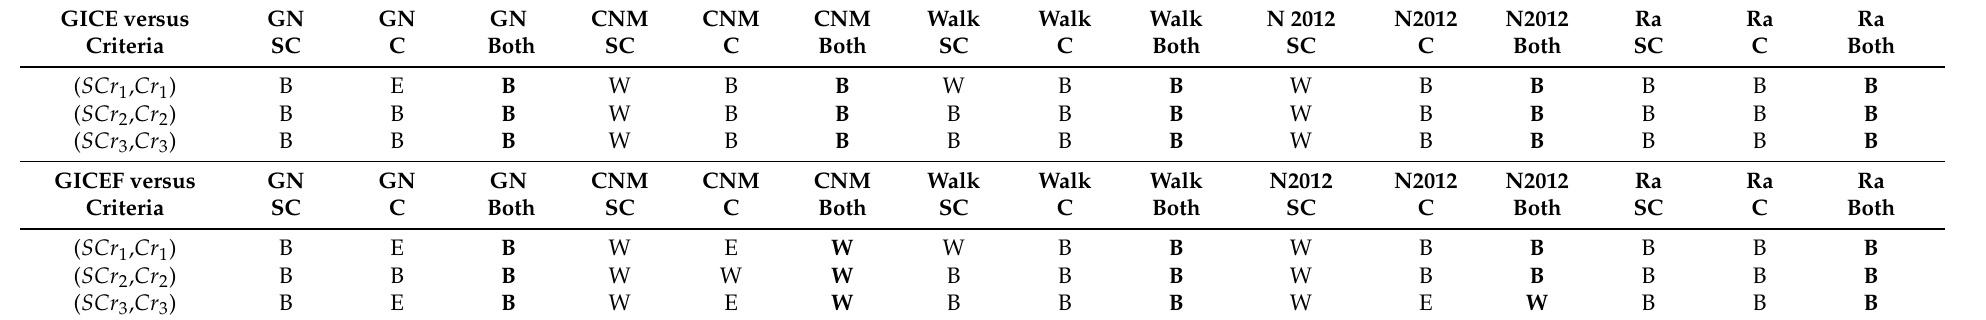
Table 6. Comparison between GICE and GICEF algorithms versus GN, CNM, Walktrap (Walk), N2012 and Radicchi (Ra) algorithms from a Modularity and Homogeneity point of view in the criteria Cr 1 , . . . Cr 3 and SCr 1 , . . . SCr 3 for the karate club network. Letter B represent that our algorithm present better performance in this criteria, W worst and E represent that the difference is not significative.